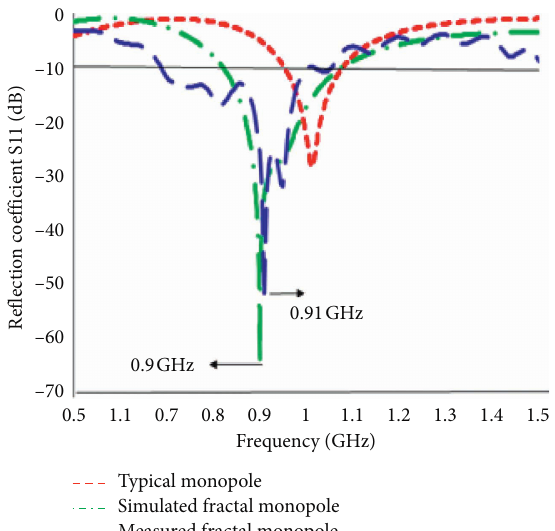
Figure 3: Simulation and measured characteristics of the reflection coefficient vs. frequency of the proposed